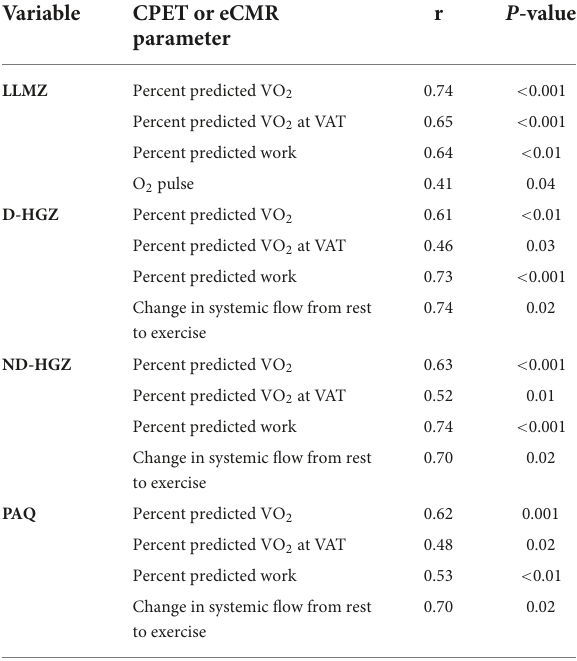
CPET, cardiopulmonary exercise test; eCMR, exercise cardiac magnetic resonance; LLMZ, leg lean mass Z-score; VO 2 , oxygen consumption; VAT, ventilatory anaerobic threshold; D-HGZ, dominant handgrip Z-score; ND-HGZ, non-dominant handgrip